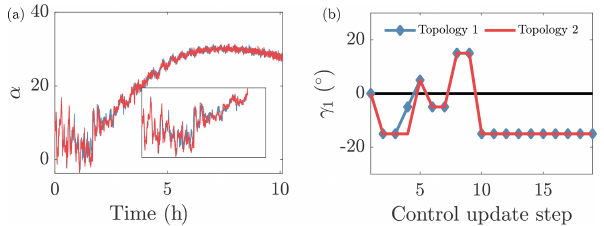
Figure C1. Diurnal cycle validation case (Kumar et al., 2006). (a) Diurnal cycle geostrophic wind speed. (b) Diurnal cycle surface heat flux w (cid:48) θ (cid:48) s .